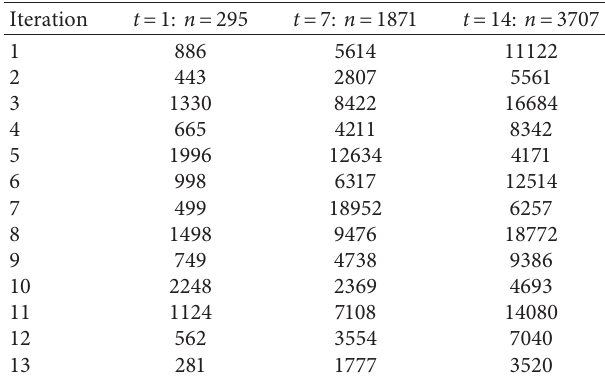
Table 3: Theorem 3 (v)